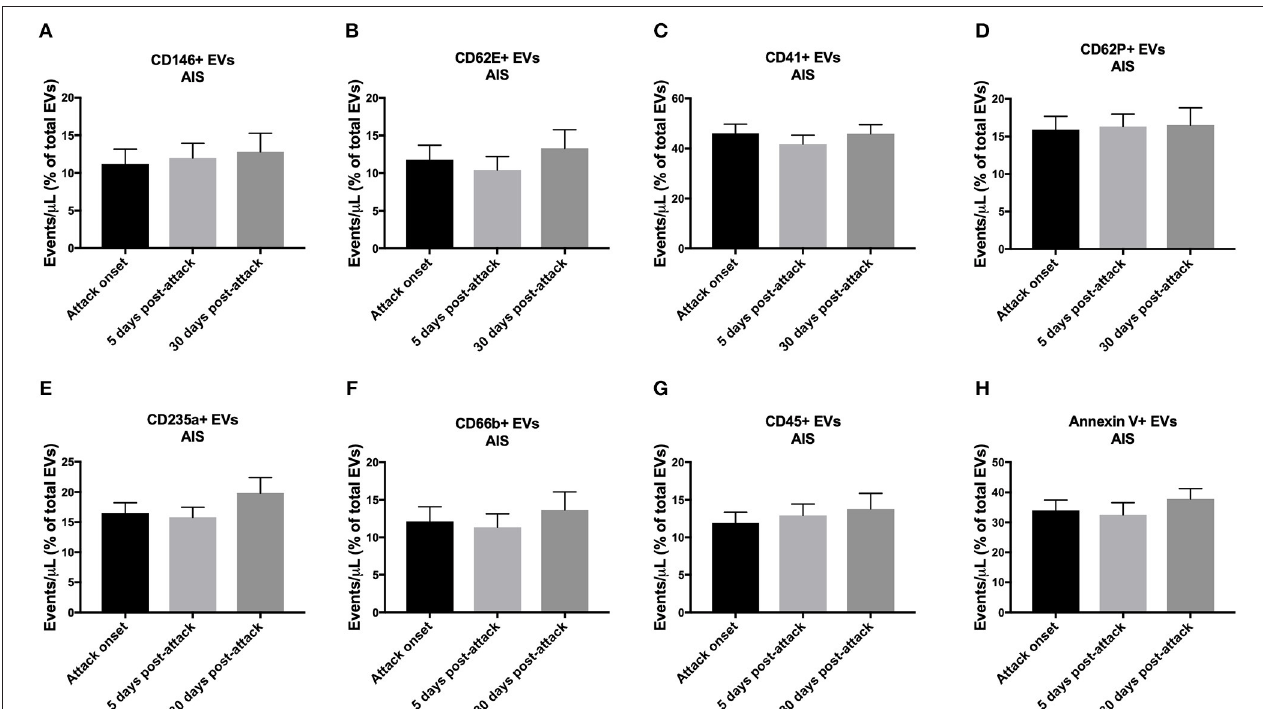
FIGURE 5 | Circulating EV levels, expressed as events/ µ L (% of total EVs), at onset, 5-days and 30-days post-attacks in PFP from patients with AIS. Histograms represent circulating levels of EVs derived from: (A) endothelial cells (CD146 + ), (B) activated endothelial cells (CD62E + ), (C) platelets (CD41), (D) activated platelets (CD62P + ), (E) erythrocytes (CD235a + ), (F) granulocytes (CD66b + ), (G) leukocytes (CD45 + ), (H) and pro-coagulant (Annexin V + ) origins. Data are expressed as mean ± SEM. AIS, n =